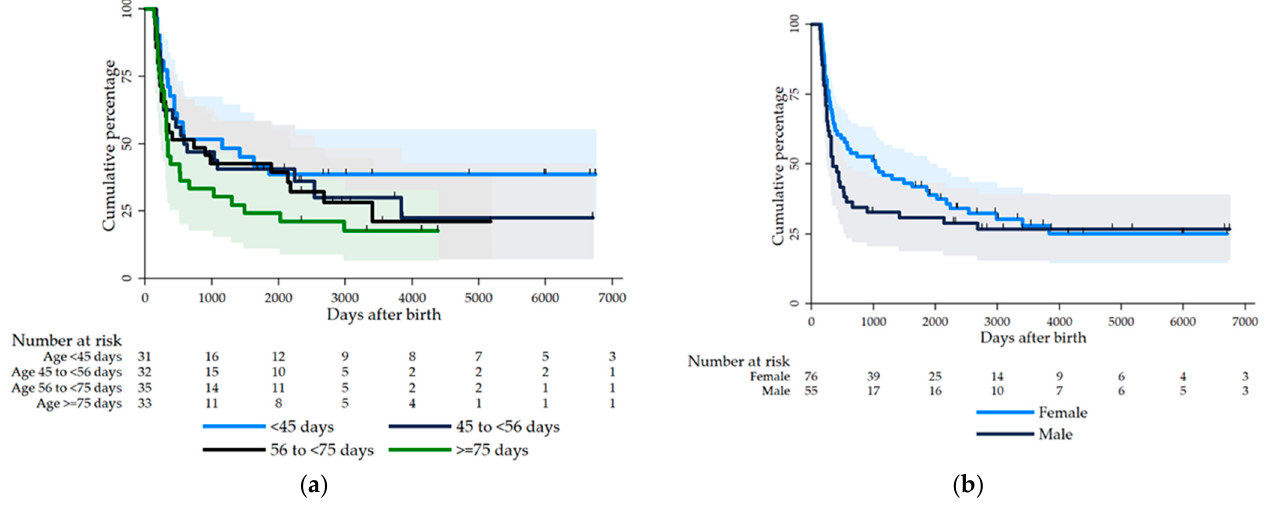
Figure 2. ( a ) Association of timing of HPE with NLS. Kaplan–Meier curves with time from birth until LT in children with BA, stratified by age at HPE, divided into four groups. ( b ) Association of sex with NLS. Kaplan–Meier curves from birth until LT in children with BA, stratified by sex (HR = 1. 41, 95%CI 0.91–2.18; p = 0.11)